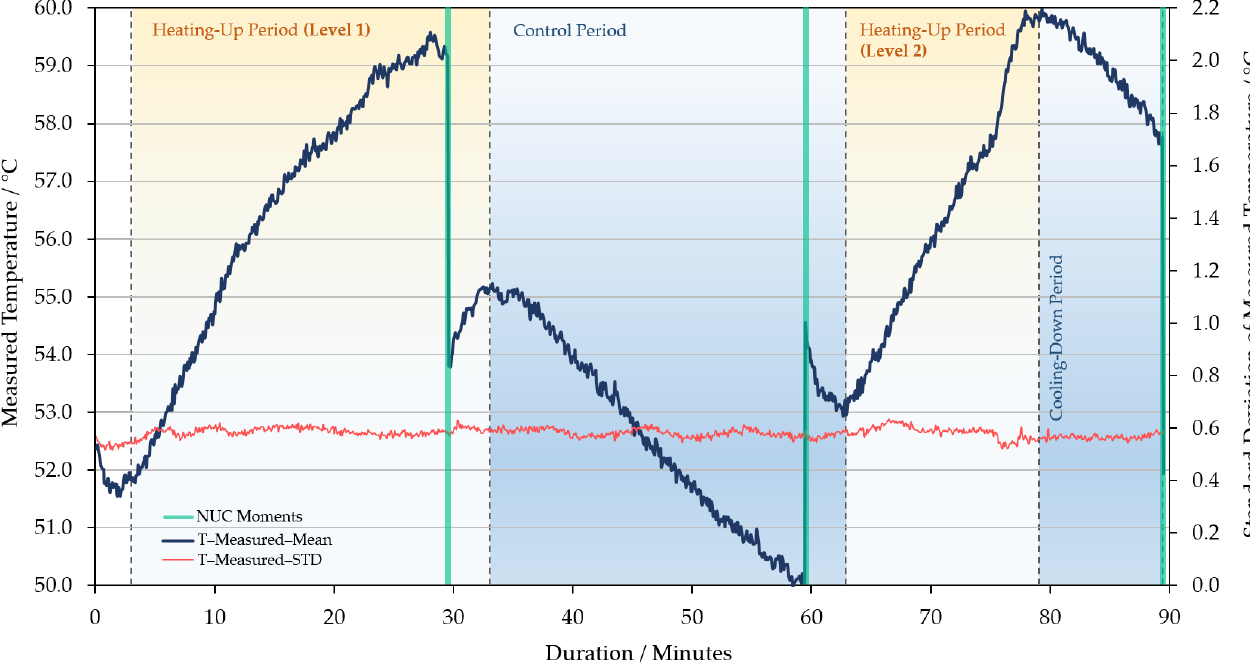
Figure 12. Simulation of the effect of (radiative) heating on WIRIS by a thermo-heater gun, while imaging a blackbody at 55 °C. A control period was set between wind tests. The STD of the measured temperature values is also included. The housing temperature is not available for this session.